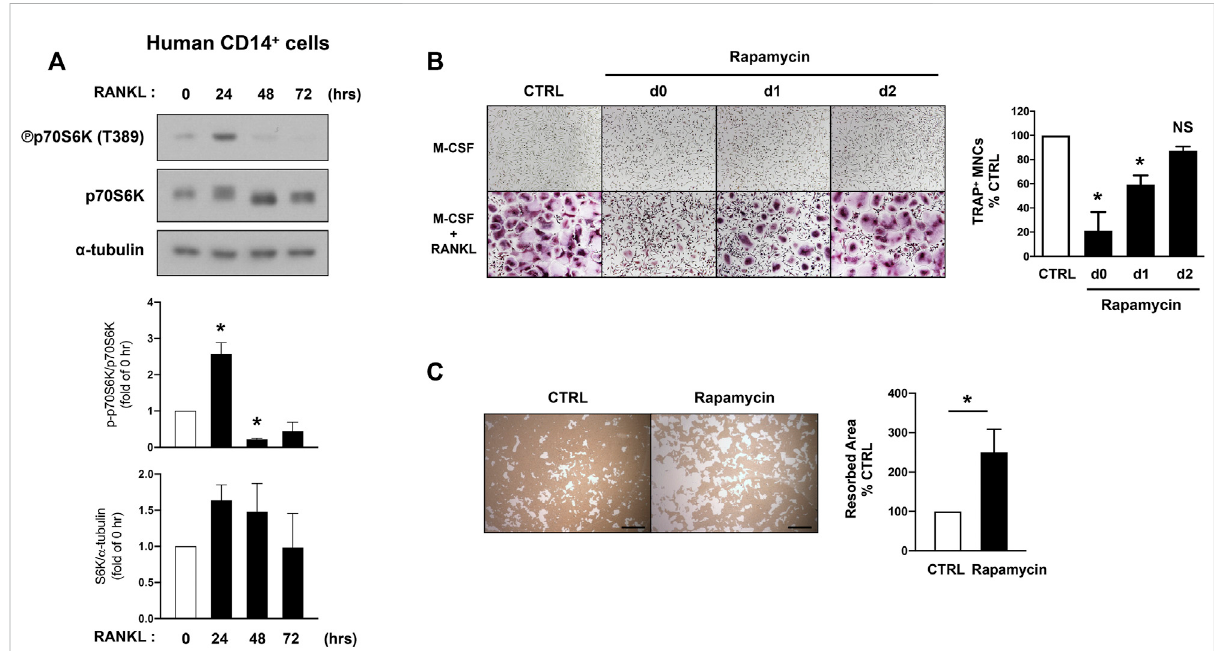
FIGURE 3 mTORC1 signaling has a biphasic effect on human osteoclastogenesis. (A) Immunoblot of whole-cell lysates from human CD14-positive cells after RANKL stimulation for the indicated time points with anti-phospho p70S6K, p70S6K, and α -tubulin antibodies. α -tubulin served as a loading control. Representative results from four independent donors are shown. Graph depicts thequanti fi cation ofsignal intensity ofthephospho p70S6K and total p70S6K immunoblot using densitometry, normalized to the control ( n = 4). (B) Representative images show human osteoclast differentiation after rapamycin treatment (100 nM) at different time points after RANKL stimulation. Graph depicts the number of TRAP-positive multinucleated cells (MNCs) counted in triplicate. Data are from four independent donors. (C) Representative images show bone resorption activity of human osteoclasts after rapamycin treatment for 48 h. Graph depicts the percentage of resorbed pit area per total area. Data are from four independent donors. Scale bar: 500 μ m. All data are shown as mean ± SEM. * p < 0.05; NS, not signi fi cant by one-way ANOVA with a post hoc Tukey test (A,B) or two-tailed, paired t test (C)